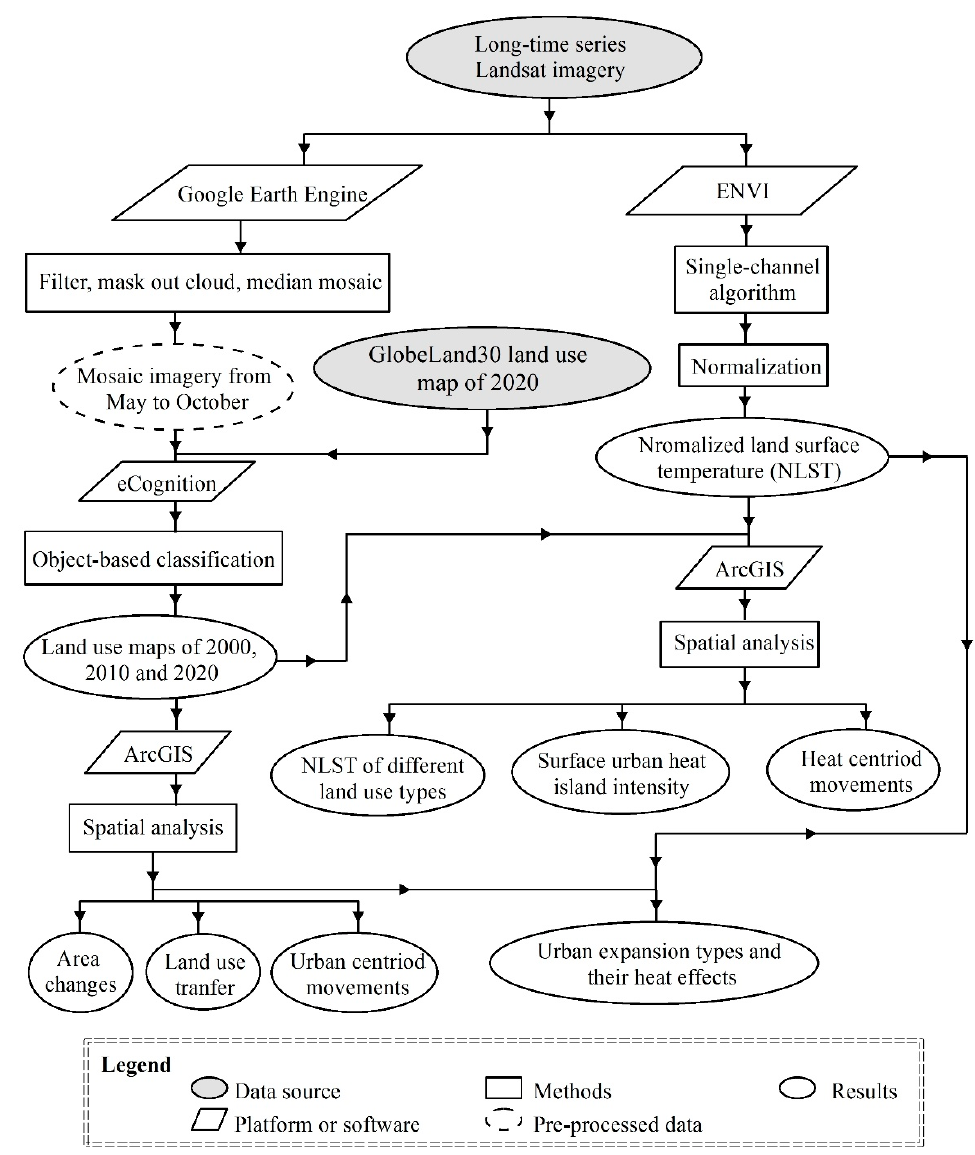
Figure 2. The workflow of this